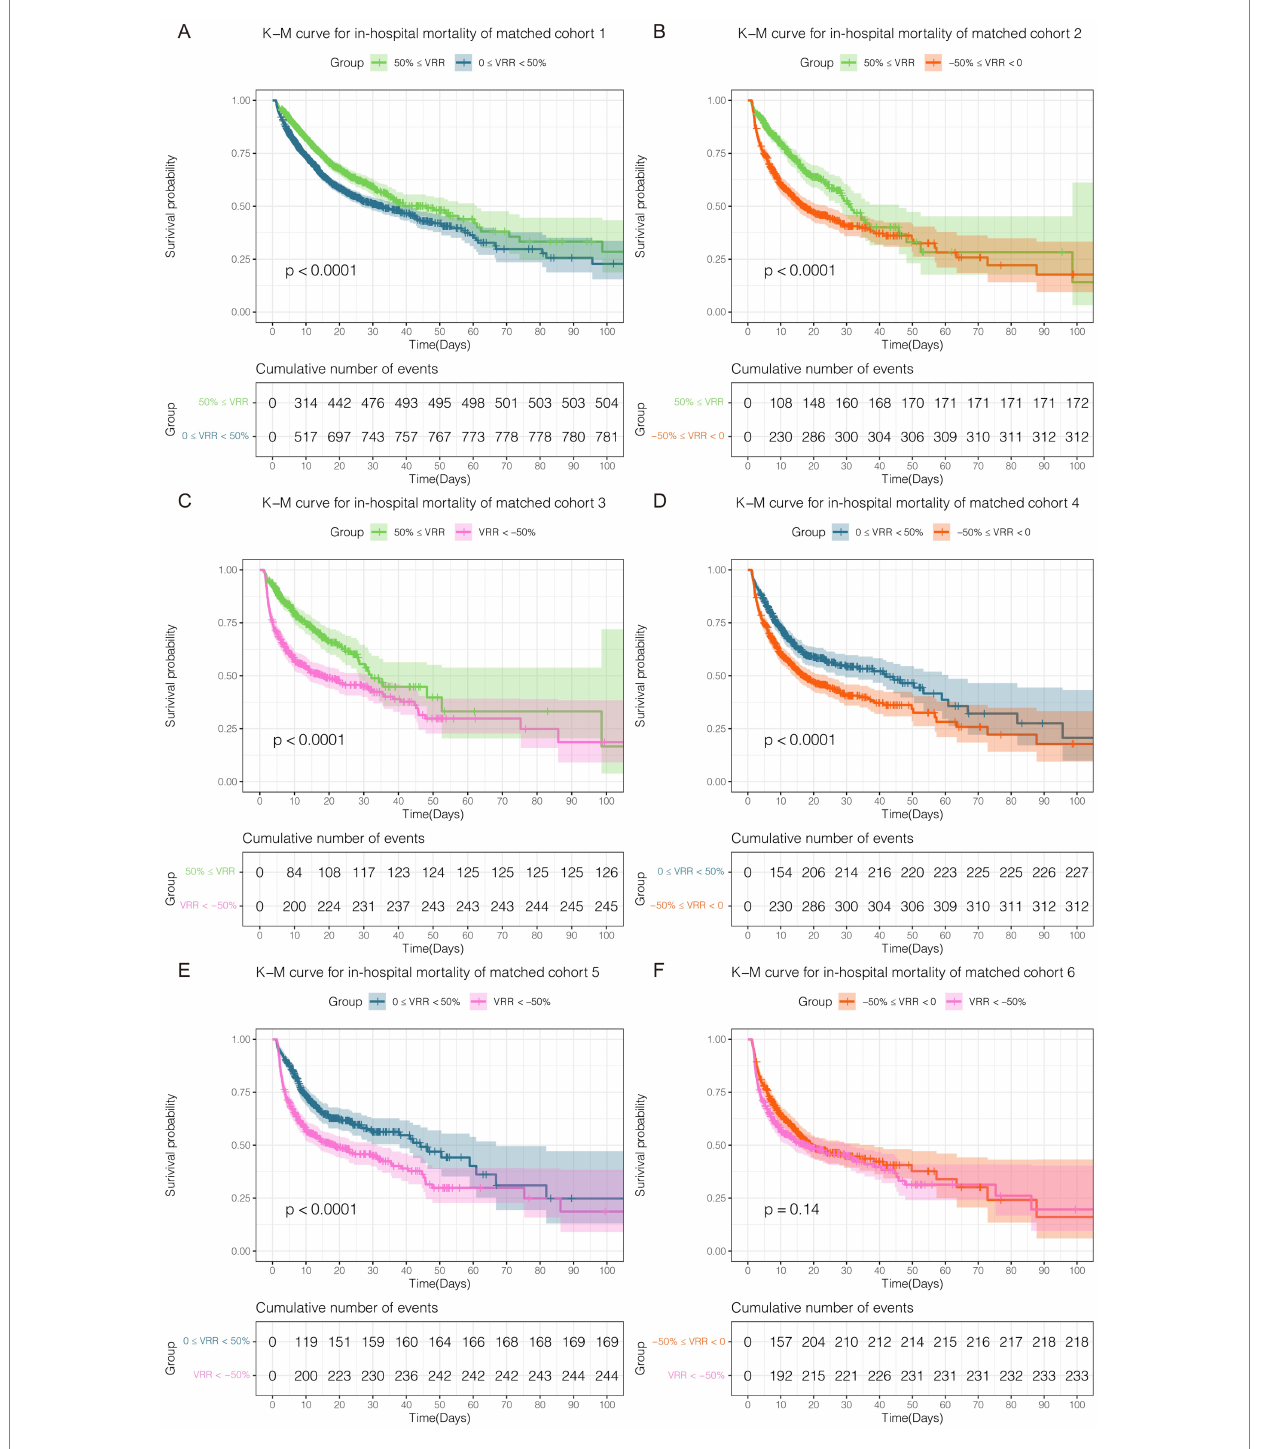
FIGURE 6 Kaplan–Meier curve for in-hospital mortality in each cohort after pairwise PSM. Except for matched cohort 6 ( F , VRR < − 50% versus − 50% ≤ VRR < 0), there were statistically significant differences between any other groups (A–E)